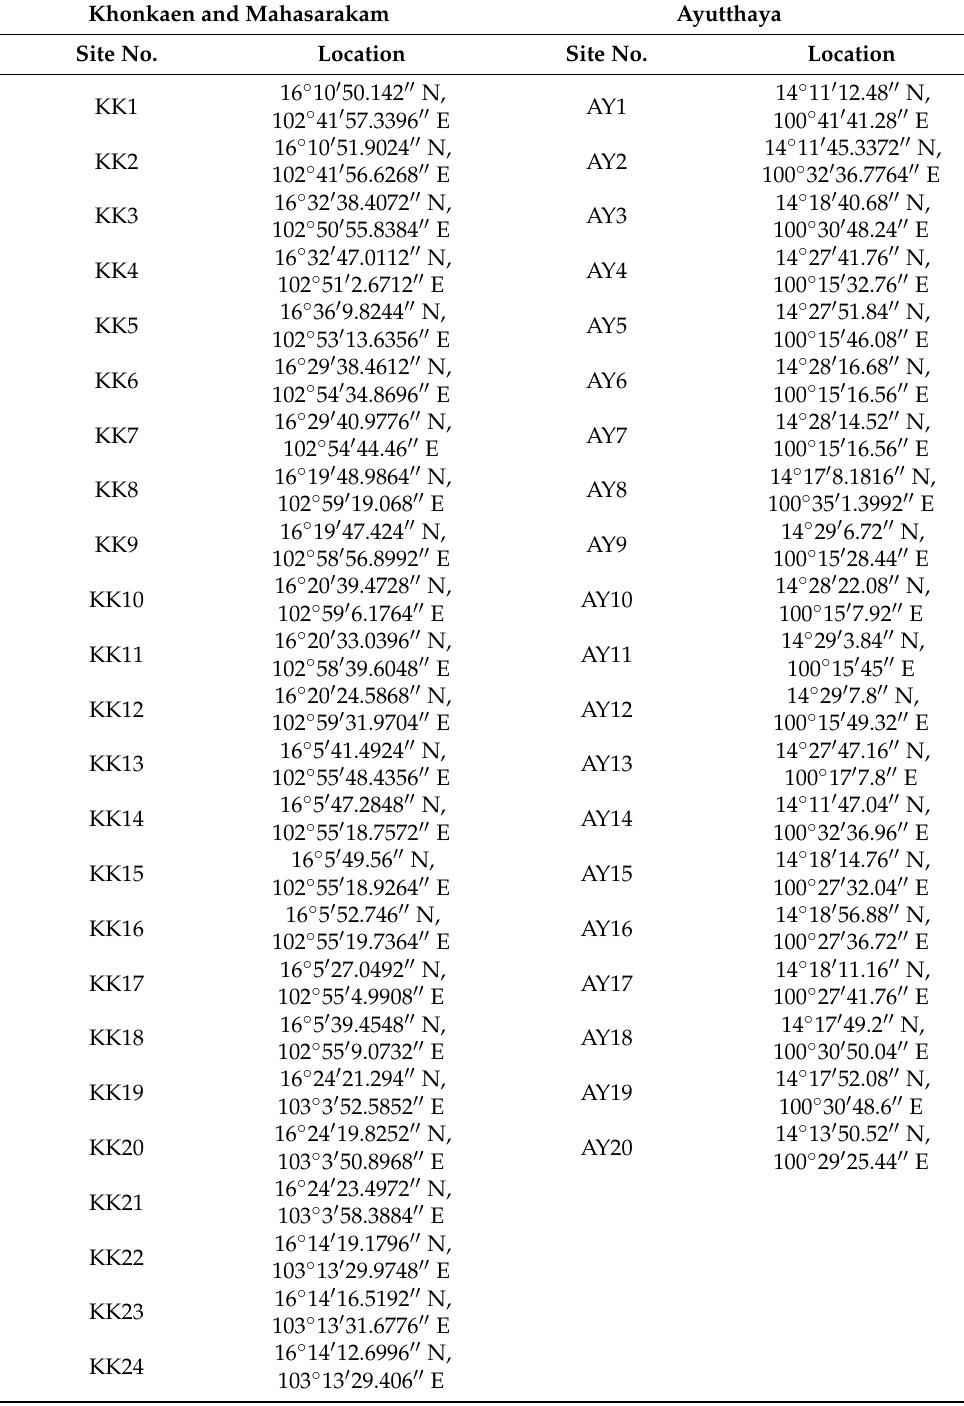
Table 1. Sampling sites from Khonkaen, Mahasarakam, and